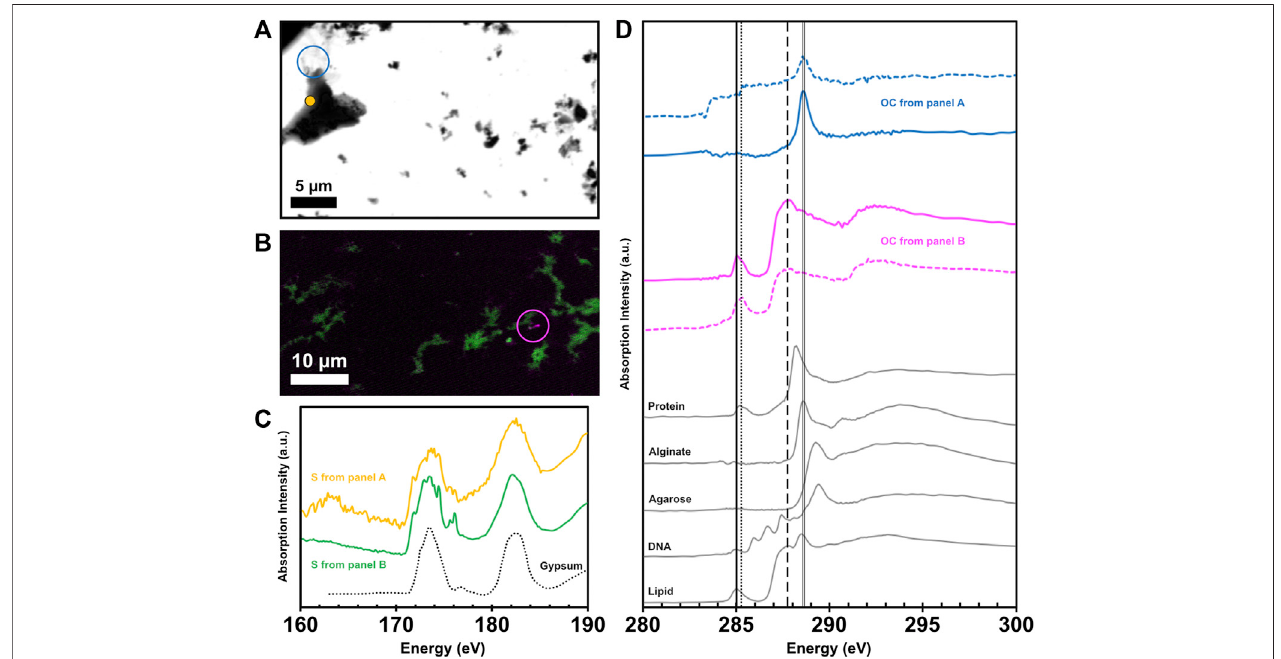
FIGURE 10 | Scanning transmission x-ray microscopy (STXM) and x-ray absorption near edge structure (XANES) spectroscopy of sulfur and organic carbon in trench core material. Two regions of core sample C4 are presented (A , B) , showing the colocation of sulfur and organic carbon (identi fi ed with sulfur and carbon XANES spectrain C and D ,respectively).ASTXMimagecollectedat320.0 eV (A) showsparticlesidenti fi edasgypsum(seerepresentativeyellowspectrum in C ,collectedfrom the location in A of the yellow circle). The blue circle in (A) shows the location of collection of the solid blue carbon spectrum at the top of (D) (the dashed blue spectrum represents organic carbon from smaller spots distributed around the largest gypsum-rich grain). A STXM map of sulfur and carbon is presented in (B) , where green represents the difference in sulfur absorptions between 170 and 172 eV, and magenta represents the difference in carbon absorptions between 280 and 288.2 eV.Thegreenspectrumin (C) representsgypsumdetectedthroughoutthegreenregionsin (B) .Themagentacirclein (B) highlightsthelocationofcollectionofthe solid magenta carbon XANES spectrum shown in the middle region of (D) (the dashed magenta spectrum represents organic carbon from smaller spots distributed throughout the material in B ). A reference spectrum for gypsum is shown in C (data adapted from Jalilehvand, 2006). Reference spectra for multiple organic carbon compounds arealso shown in (D) .Thesereferencedata arereported byChanet al.(2010) and areasfollows: aprotein (bovine serum albumin;BSA), alginate (anacidic polysaccharide), agarose (a neutral polysaccharide), a sample of DNA, and a lipid (1,2-dipalmitoyl-sn-glycero-3-phosphoethanolamine). Vertical lines, included to highlightthecarbonfunctionalgroupsinthesamplespectra,represent thefollowingcarbonfunctionalgroups:unsaturatedoraromaticcarbon(1s → π *C=C;solidlineat 285.2 eVanddottedlineat 285.4 eV);aliphaticcarbon,aromaticcarbonyl,ketones,and/or phenols(1s → σ ;dashed lineat287.6 eV);andcarboxyl(1s → π *C=O;double lines; 288.6 eV; see references in the